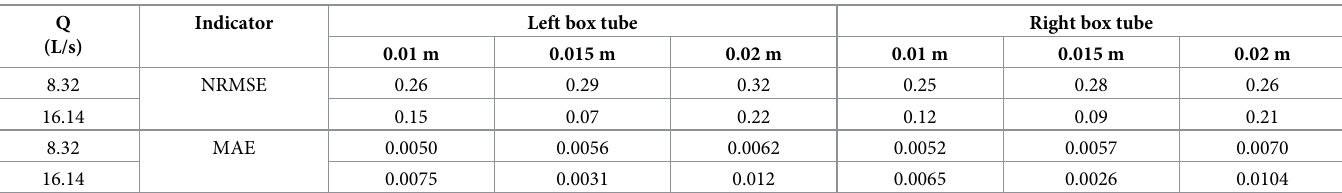
Table 3. NRMSE and MAE indicators of pressure head.